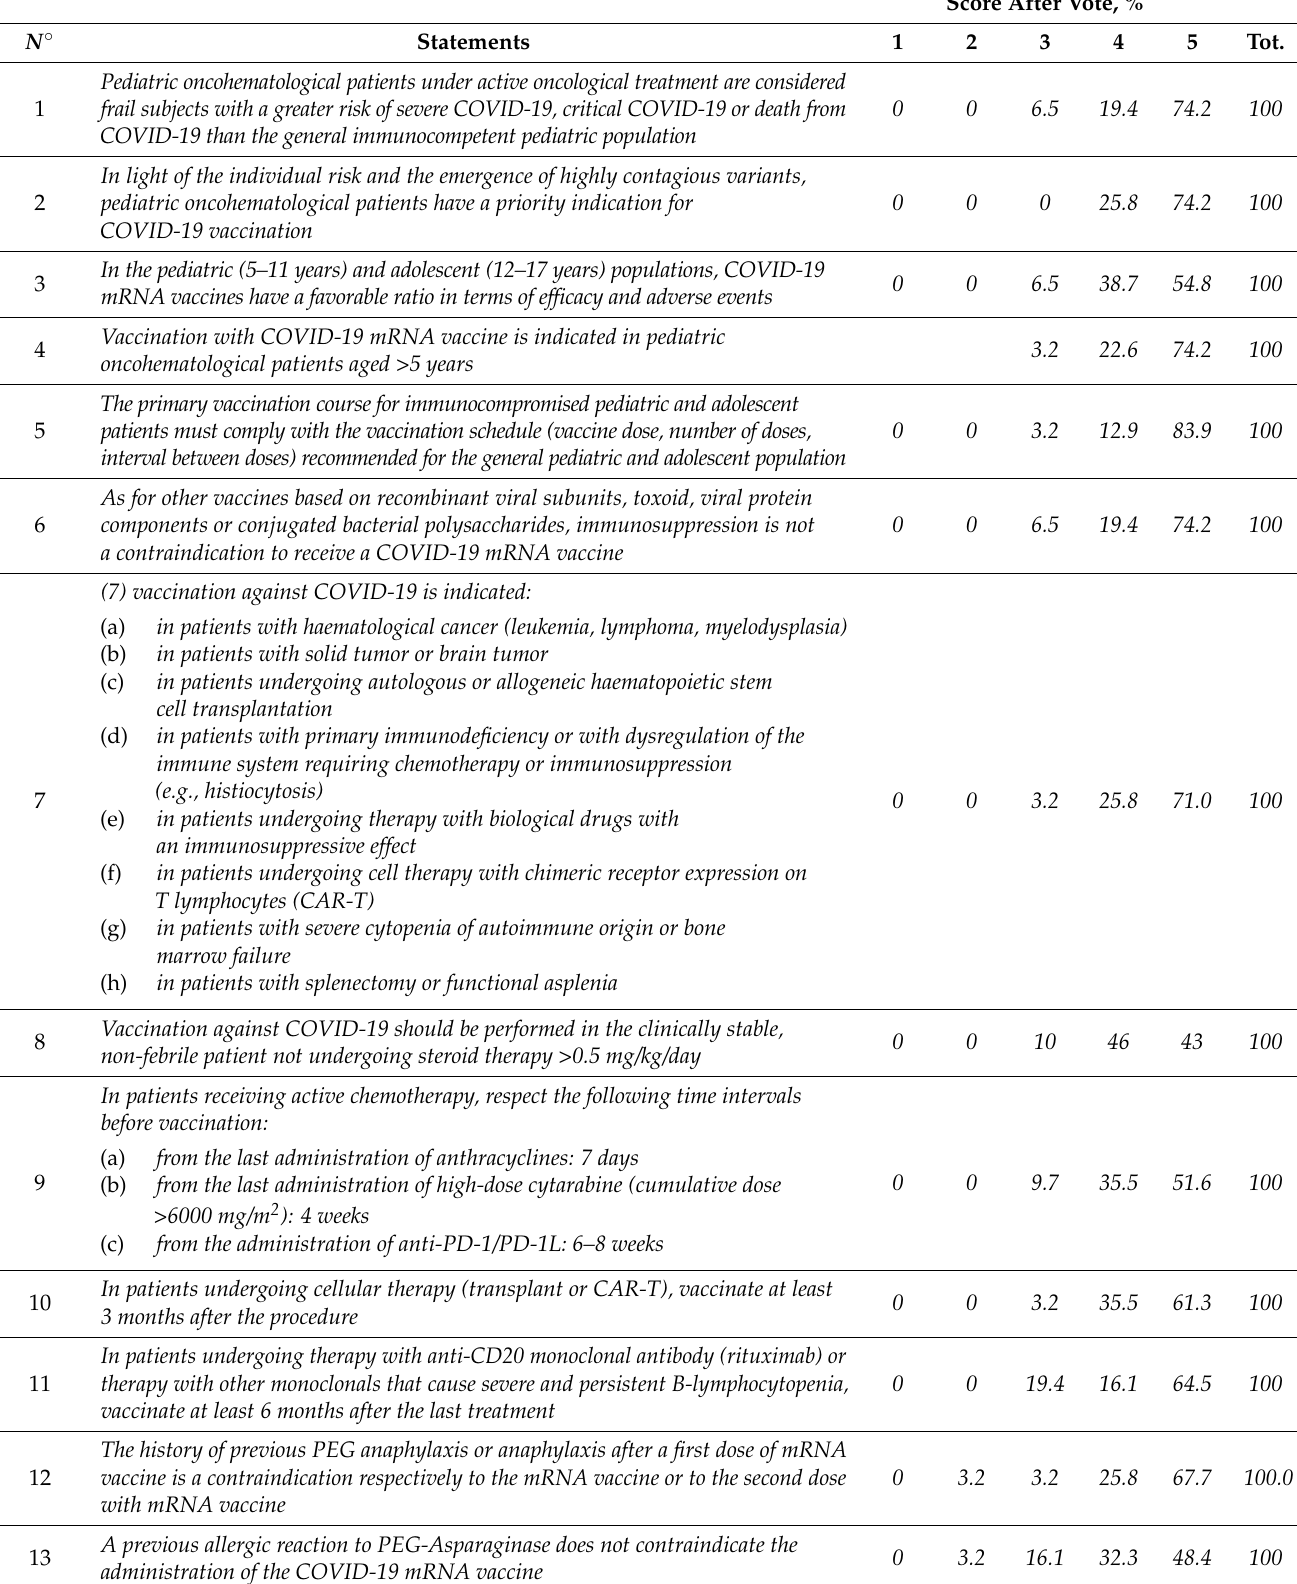
Score After Vote,